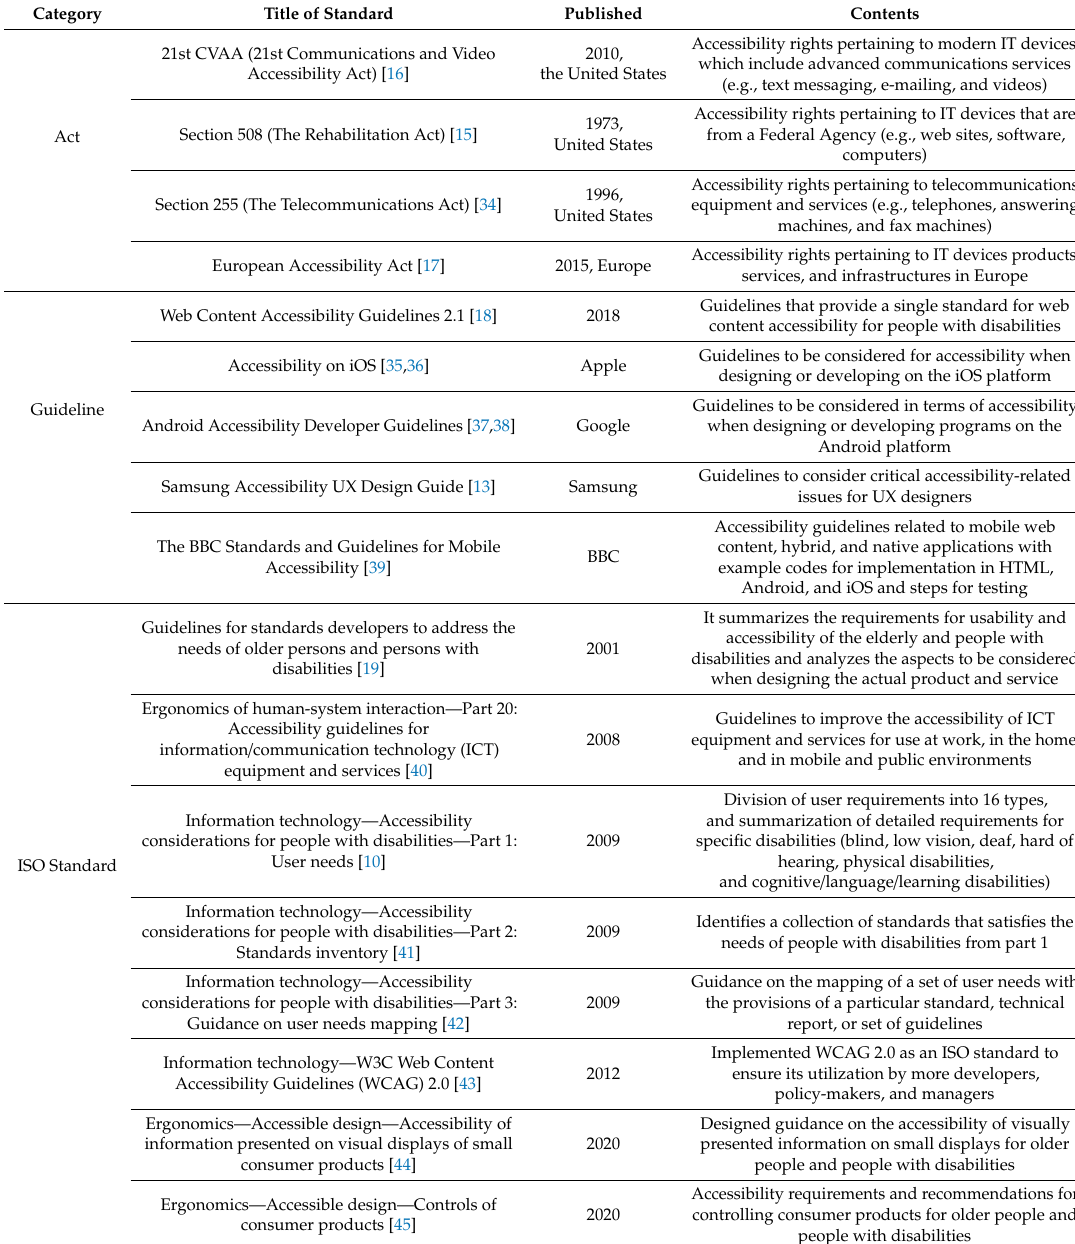
Table 6. Major accessibility acts / guidelines /